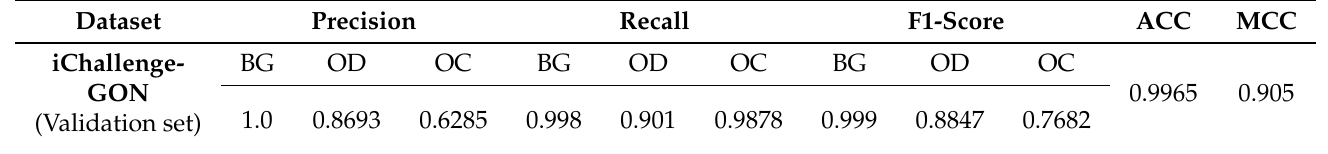
Table 4. Results from validation of trained model (U-Net) for OD/OC segmentation.